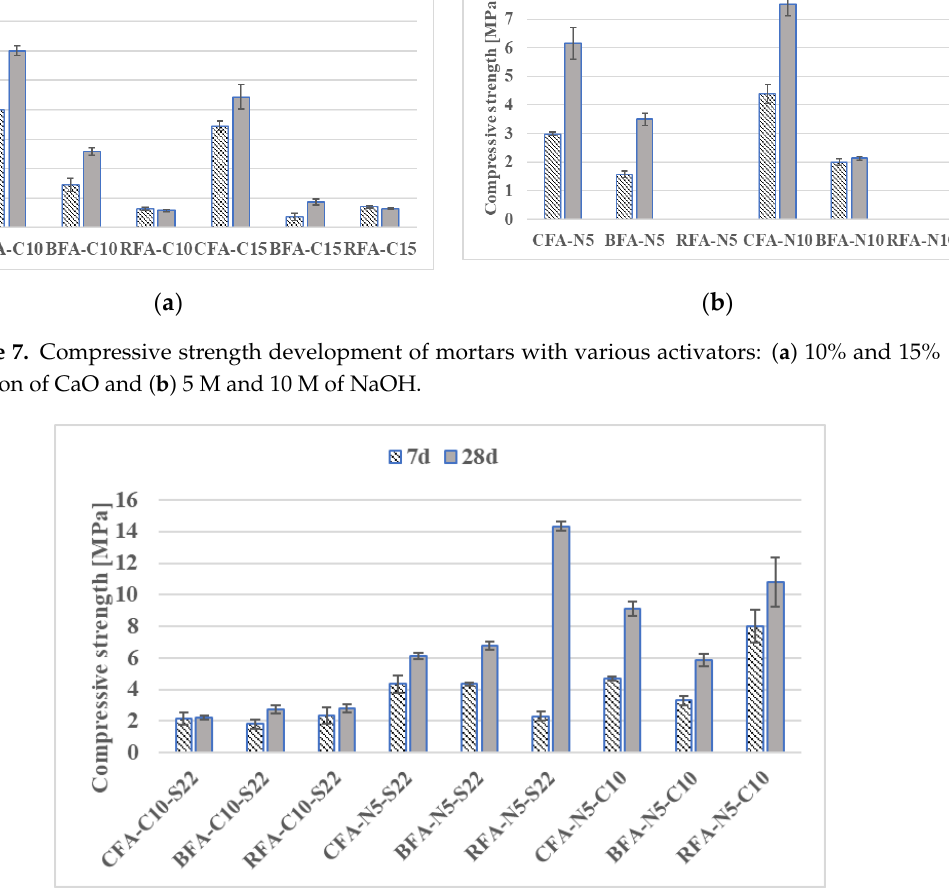
Figure 8. Compressive strength development of mortars with mixed activators.